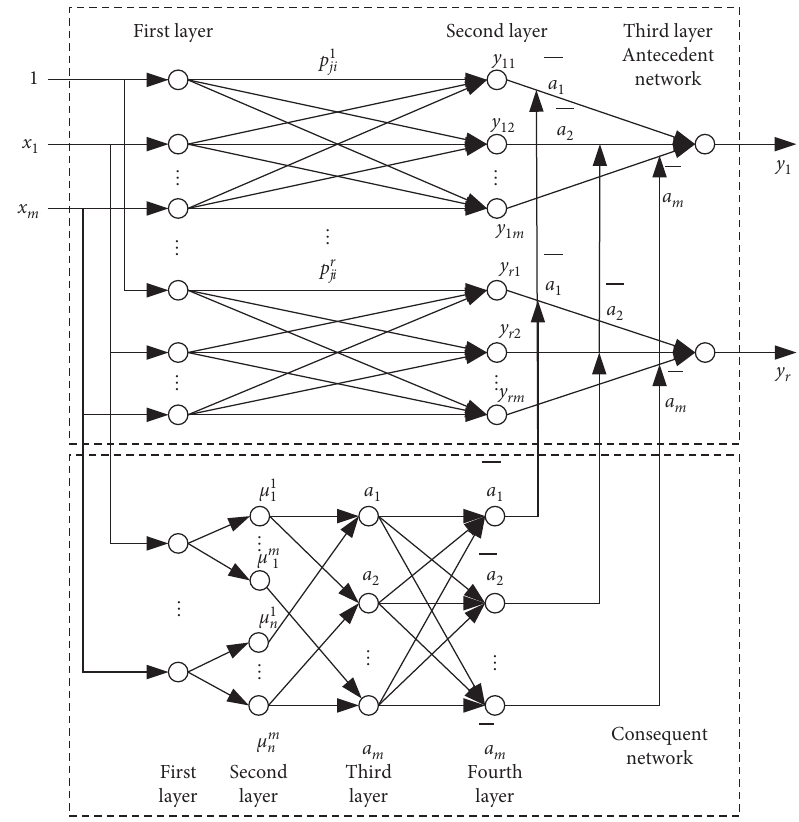
Figure 1: Structure of T-S fuzzy neural